Question: What form of chart is displayed?
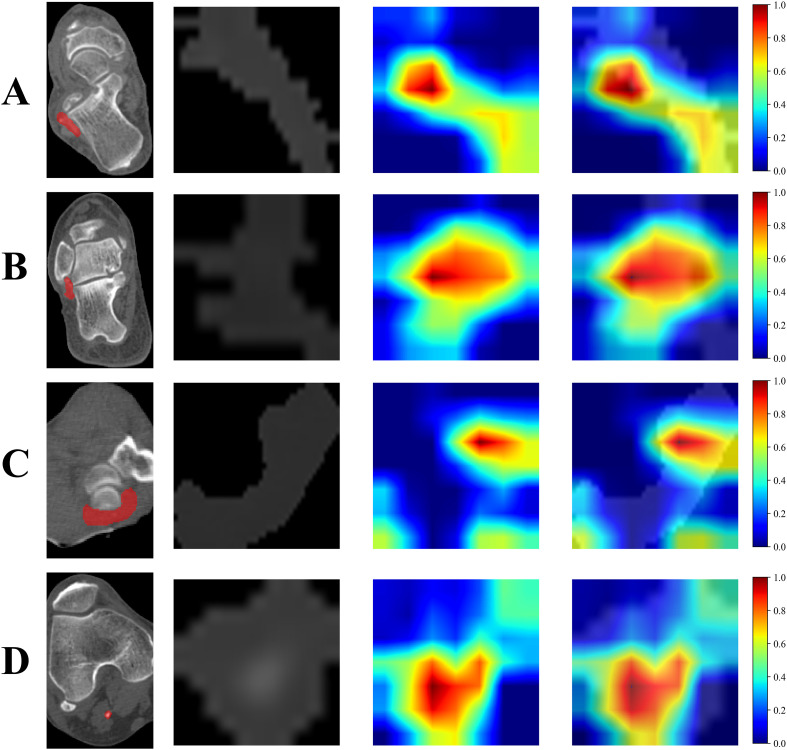
Answer: heatmap